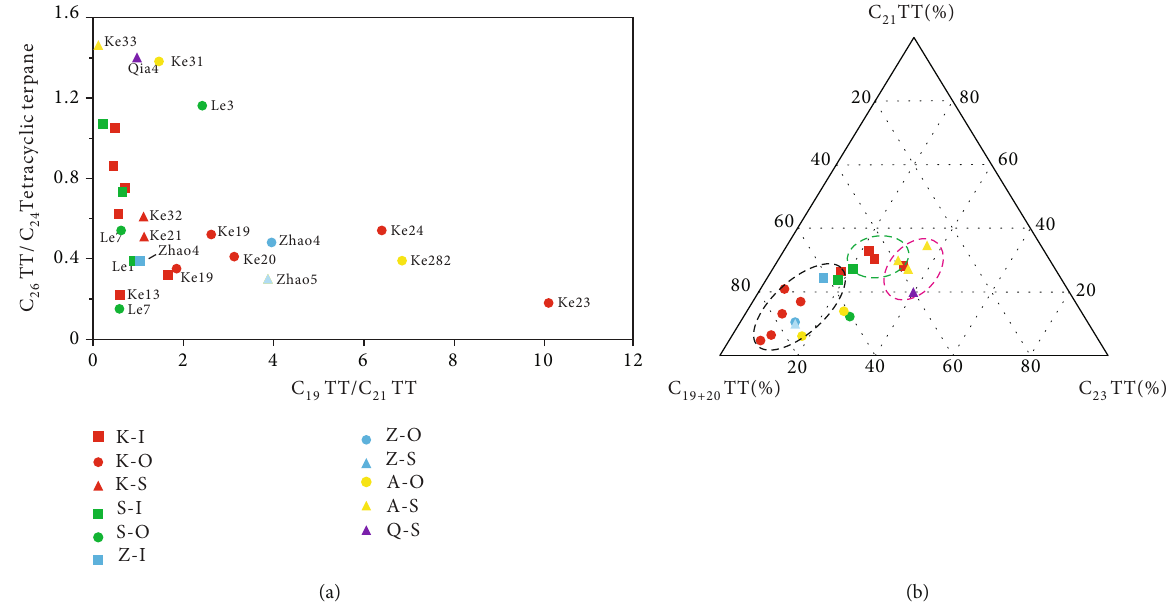
Figure 6: The characteristics of tricyclic terpanes in the inclusions, oil and sandstones of the northern piedmont belt of the Turpan-Hami Basin. (a) Cross-plot of C and sandstone. Note: K-I: Kekeya-inclusion; K-S: Kekeya-sandstone; K-O: Kekeya-crude oil; S-I: Shanle-inclusions; S-O: Shanle-crude oil; Z- I: Zhaobishan-inclusions; Z-O: Zhaobishan-crude oil; Z-S: Zhaobishan-sandstone: A-O: Aketashi-crude oil; A-S: Aketashi-sandstone; Q-S: